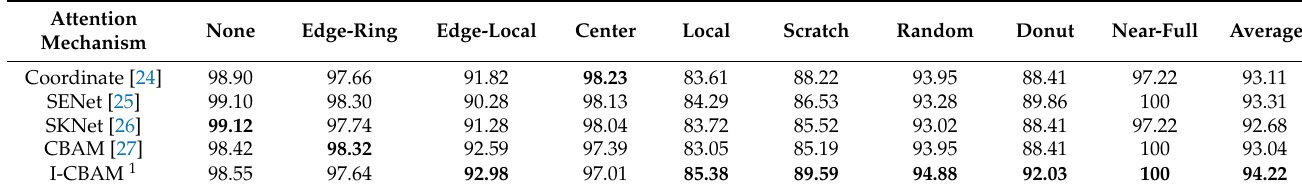
Table 2. Classification accuracies when integrating different attention mechanisms (%).